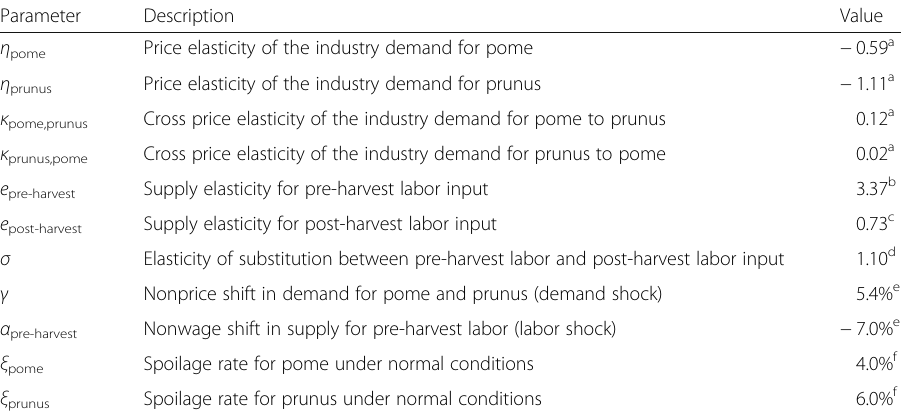
Table 1 Parameters and shocks Parameter Description Value Price elasticity of the industry demand for pome Price elasticity of the industry demand for prunus